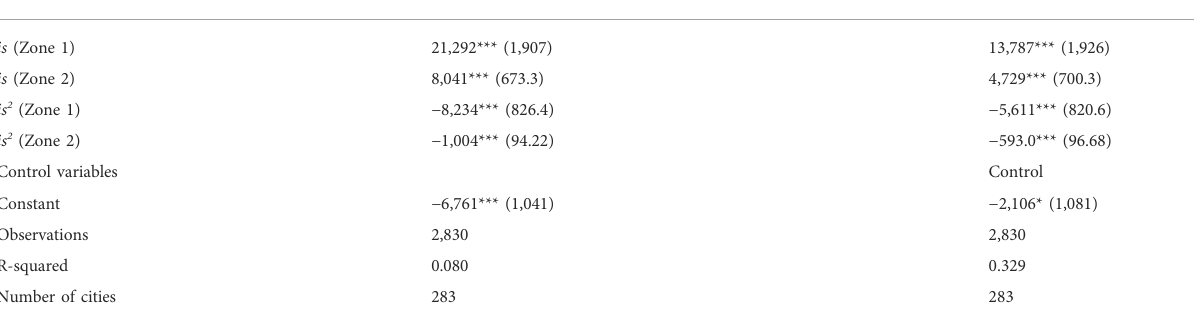
TABLE 6 Threshold model estimation